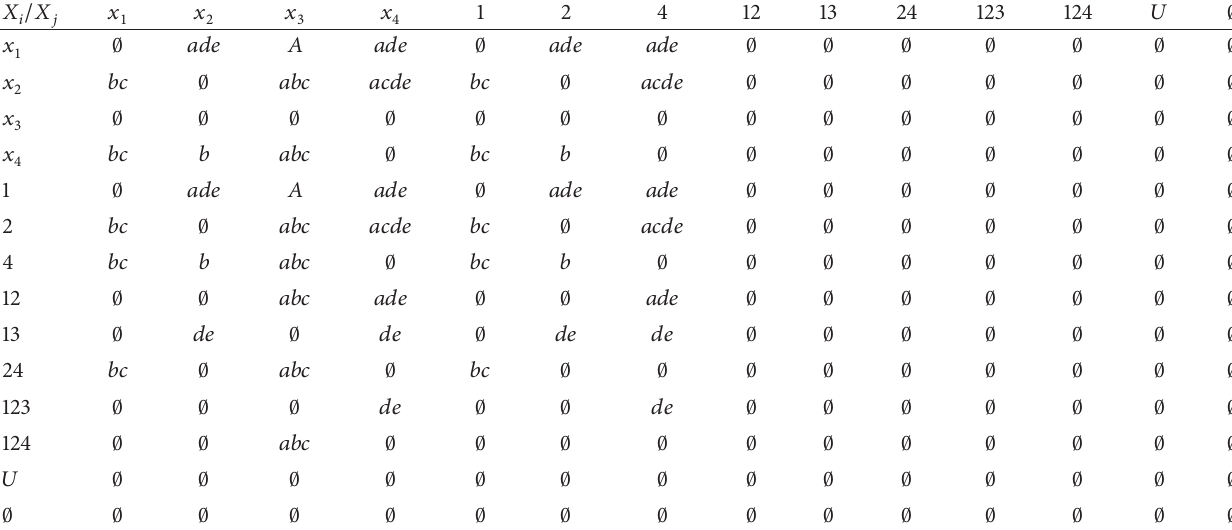
Table 2: Discernibility matrix in Example 22.